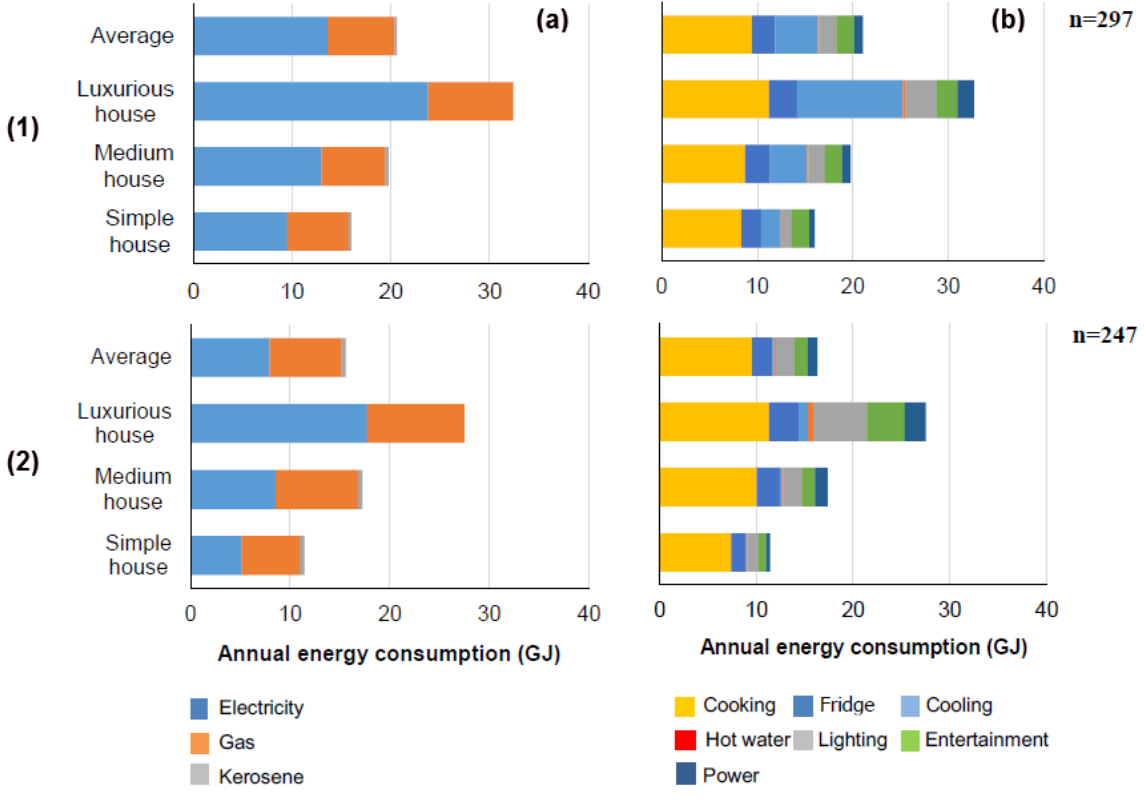
Figure 8. Annual household energy consumption by house category in ( 1 ) Jakarta and ( 2 ) Bandung, ( a ) by energy source and ( b ) end